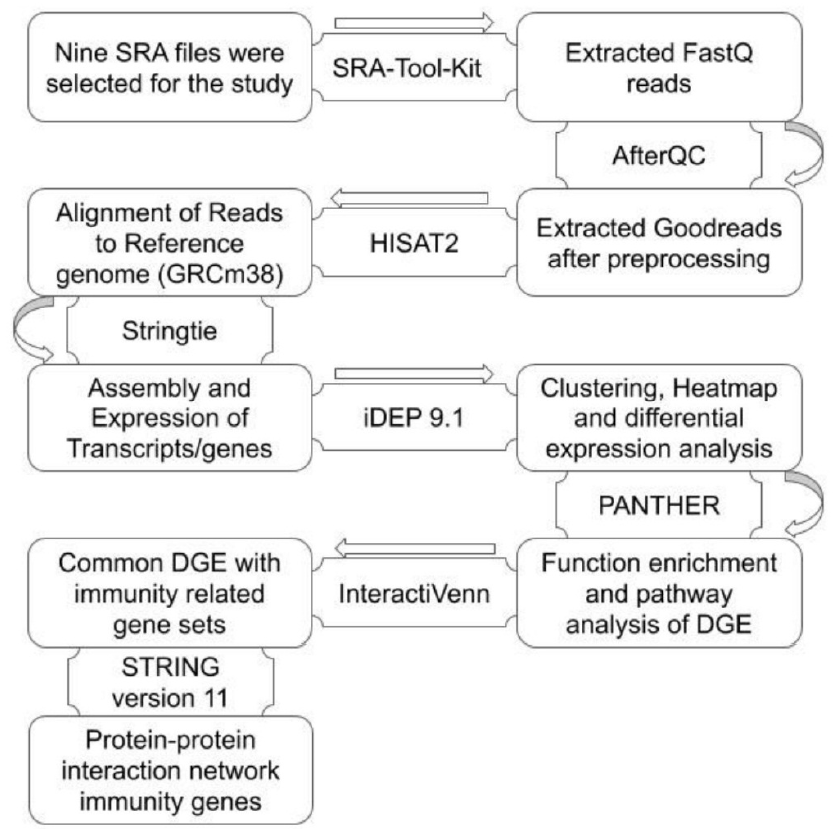
Figure 1. Flowchart of the methodology.